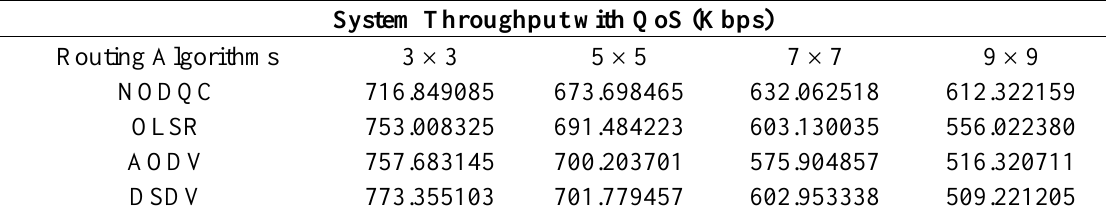
Table 12. Experiment results of routing algorithms (system throughput with QoS).